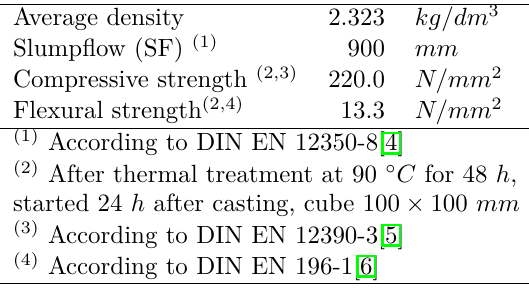
Table 2. The basic material parameters of the con- crete used.